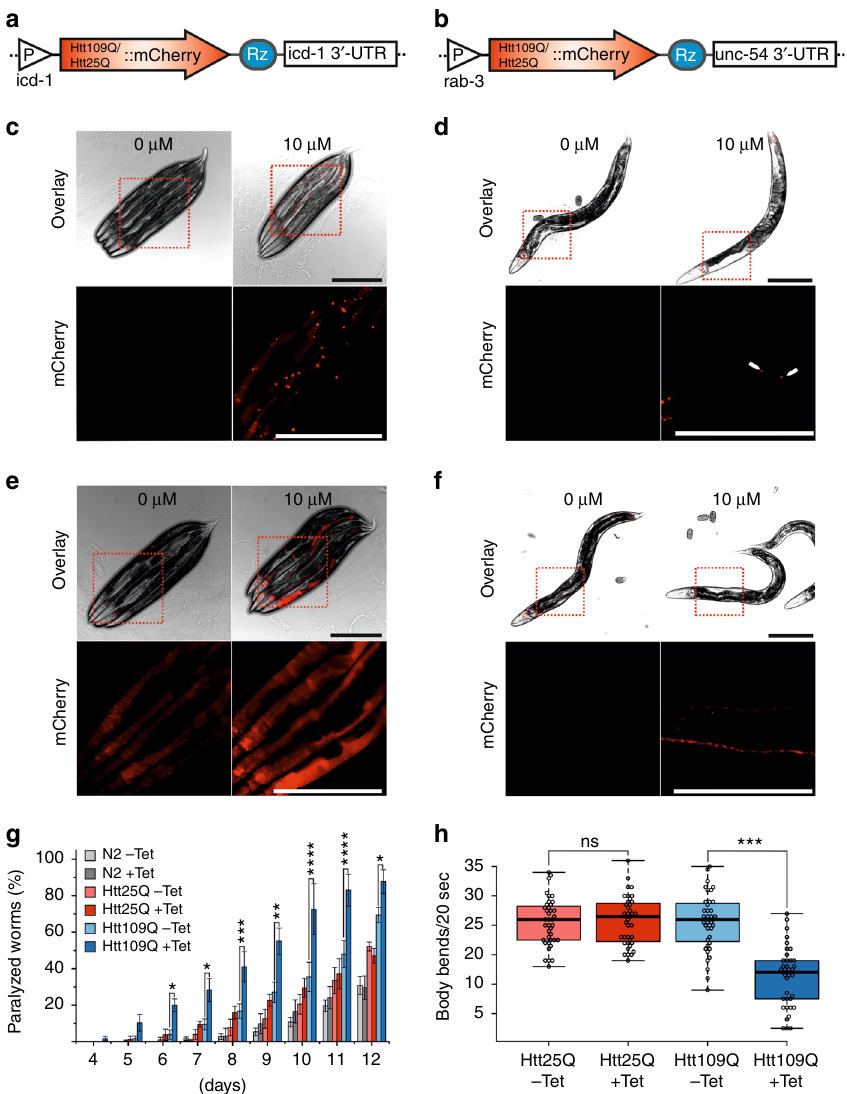
Fig. 4 Aptazyme-inducible proteotoxic C. elegans disease models. a , b Schematics showing constructs for inducible expression of human Huntingtin exon 1 (Htt) containing a polyglutamine stretch of either 109 (Htt109Q) or 25 glutamines (Htt25Q) fused to mCherry driven either by the ubiquitous promoter icd-1p ( a ) or the pan-neuronal promoter rab-3p ( b ). Rz, ribozyme. c Microscope images of worms carrying icd-1p::Htt109Q::mCherry construct. Animals were fed 10 µ M tetracycline from hatch until adulthood (3 days, 20 °C). Upper row shows overlay of bright fi eld images with mCherry fl uorescence. Fluorescence signal in boxed sections is shown enlarged to visualize Htt109Q::mCherry aggregates (bottom row). Scale bar, 300 µ m. d Same analysis as in c but with rab-3p::Htt109Q::mCherry strain. White arrows indicate Htt109Q::mCherry inclusion bodies. e , b Same analysis as in b and c but with Htt25Q:: mCherry worms, respectively. g Strains carrying the constructs shown in a were treated with 10 µ M tetracycline from hatch. N2 worms served as wildtype control. Diagram shows the percentage of paralyzed worms at indicated days of adulthood. Error bars, s.d. * p < 0.05, ** p < 0.01, *** p < 0.001, **** p < 0.0001. Two-Way ANOVA, Bonferroni post-hoc test; n = 3. h Strains carrying the constructs shown in b were treated with 10 µ M tetracycline from hatch until day 2 of adulthood (4 days at RT). Box plot shows the number of body bends made by worms in a drop of liquid in 20 s. *** p < 0.001 (two-tailed t - test); ns not signi fi cant; n = 40. Center line = median; box length = upper + lower quartile; whiskers = minimum/maximum quartile. Source data